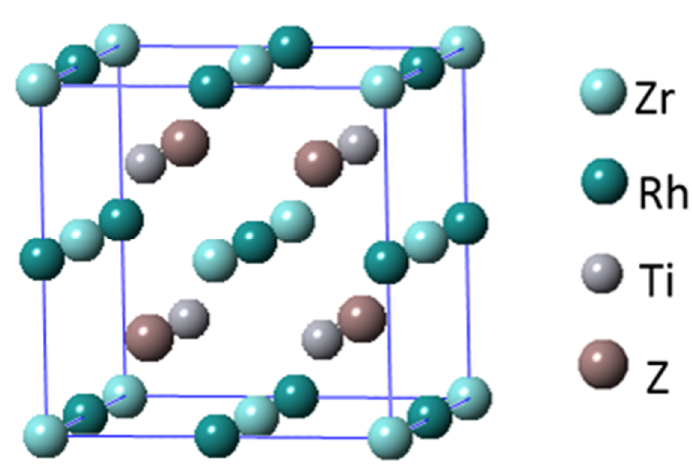
Figure 1. Crystal structure of ZrRhTiZ (Z = Al, Ga) quaternary Heusler compounds.